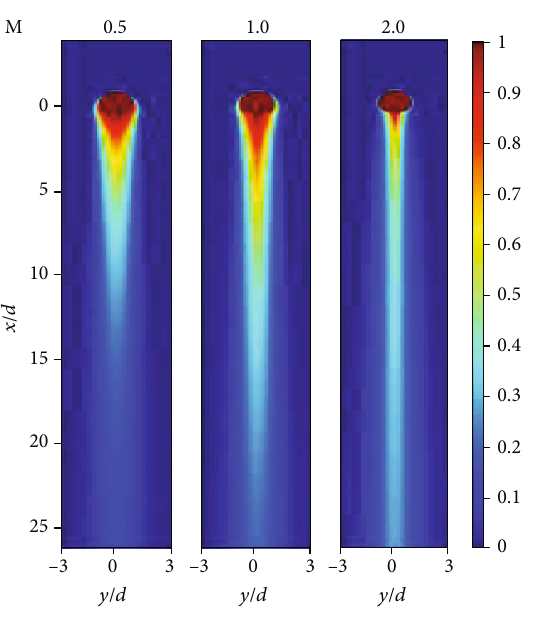
Figure 12: Experimental contours of θ = 21 ° .